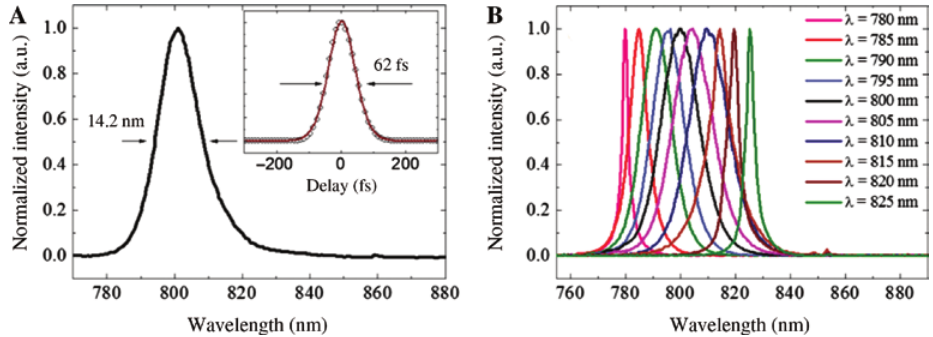
Figure 11: SWCNT SA mode-locked Ti:sapphire laser. (A) Spectrum and ACF with sech 2 pulse shape fit (inset) and (B) spectral tuning. Baek et al. [9]. © Optical Society of America